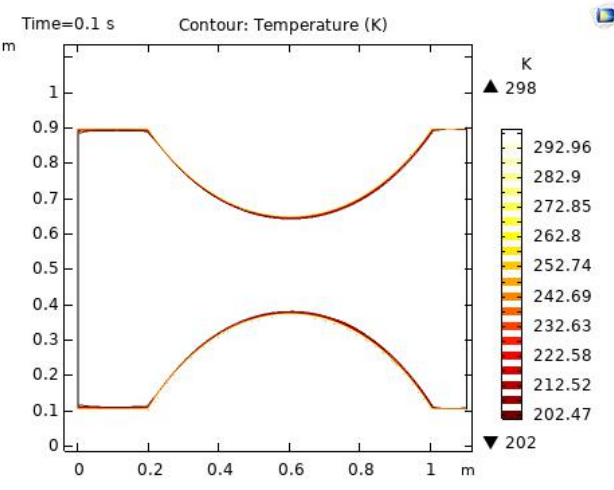
Figure 17. The isothermal contour profile at t = 0.1 s.